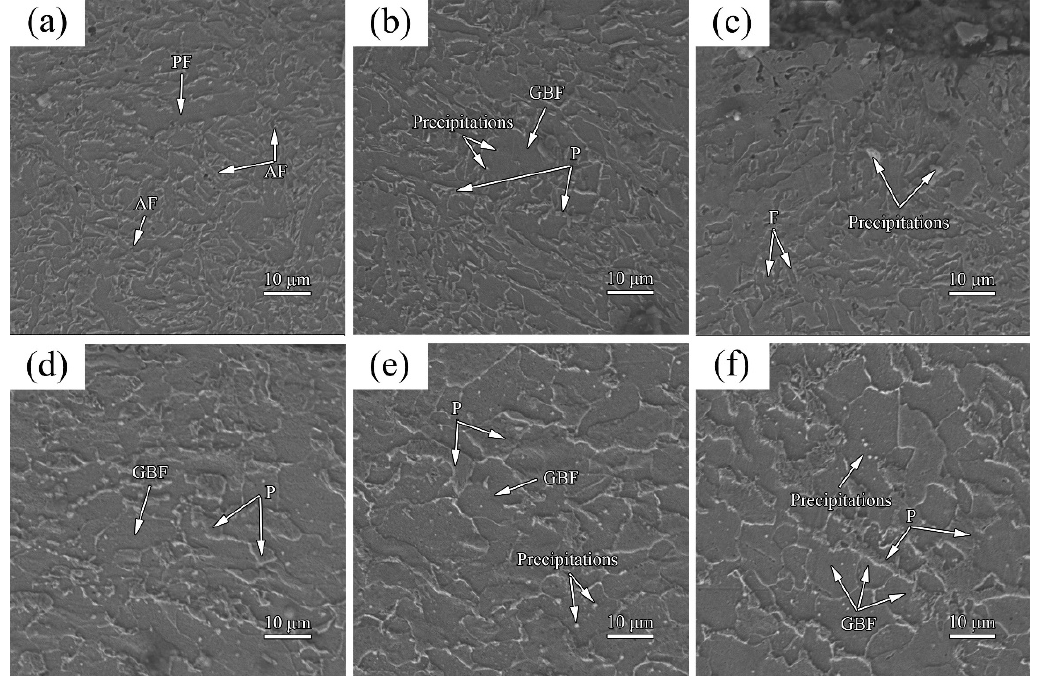
Figure 4. Microstructure morphology for RZ at different positions of the LSM process-treated samples: ( a ) bottom of sample 1; ( b ) middle of sample 1; ( c ) top of sample 1; ( d ) bottom of sample 2; ( e ) middle of sample 2; and ( f ) top of sample 2. (F—ferrite; P—pearlite; PF—polygonal ferrite; GBF—grain boundary ferrite; and AF—acicular ferrite).